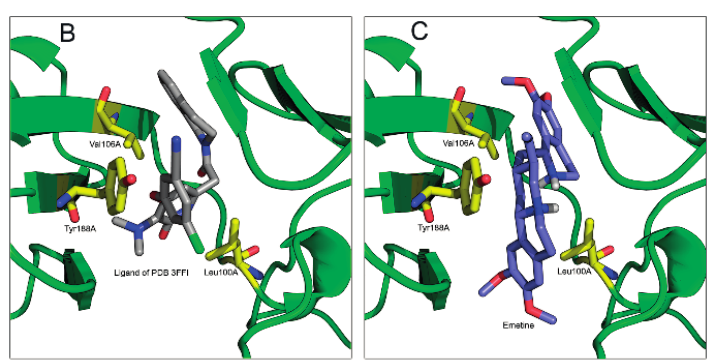
Figure 2. Emetine docking on RT-HIV in comparison with a pyridone analogue. ( A ) Representation of emetine and the pyridone non-nucleosidic analogue binding to RT. The main amino acid residues on compounds binding to RT are presented. Green lines represent hydrophobic pockets, while ref residues indicate interactions observed for both compounds; ( B ) Crystallographic complex between emetine pyridone analogue and RT, and ( C ) RT-emetine complex derived from docking calculations. Common amino acid residues for both complexes are indicated as yellow sticks.